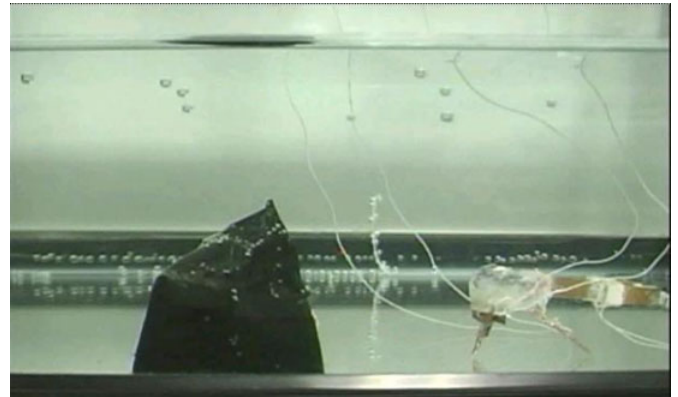
Figure 12 Floating motion for avoiding